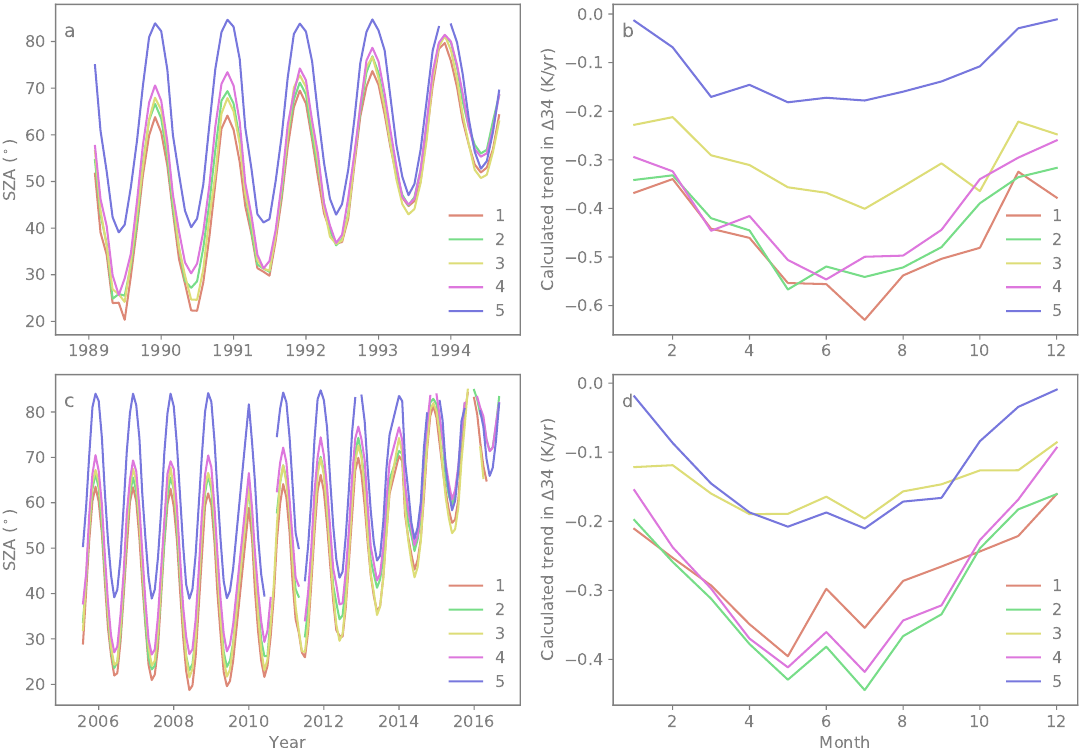
Figure 3. Sun zenith angle (SZA) and calculated monthly trends in (cid:52) BT 34 shown for the five study regions for NOAA-11 and NOAA-18. Both platforms exhibit a pronounced orbital drifting indicated by the increase in SZA over each platforms life time, whereby NOAA-11 ( a ) experiences a stronger drift over a shorter lifetime compared to NOAA-18 ( c ). Note, that NOAA-18 was drifting towards noon until 2009, resulting in lower SZA values. The gap in year 2009 of the NOAA-18 time series in region 5 results from clouds obscuring the region. Panels ( b ) for NOAA-11 and ( d ) for NOAA-18 illustrate the calculated monthly mean trends in (cid:52) BT 34